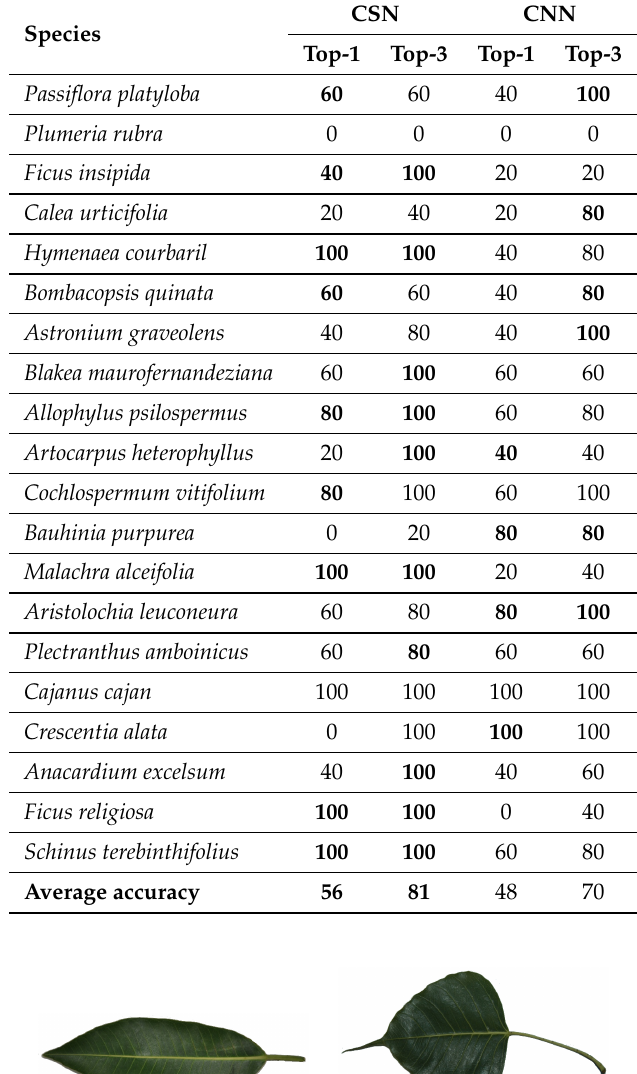
Table 3. Experiment 2: accuracy/species for 20 Costa Rican tree species.